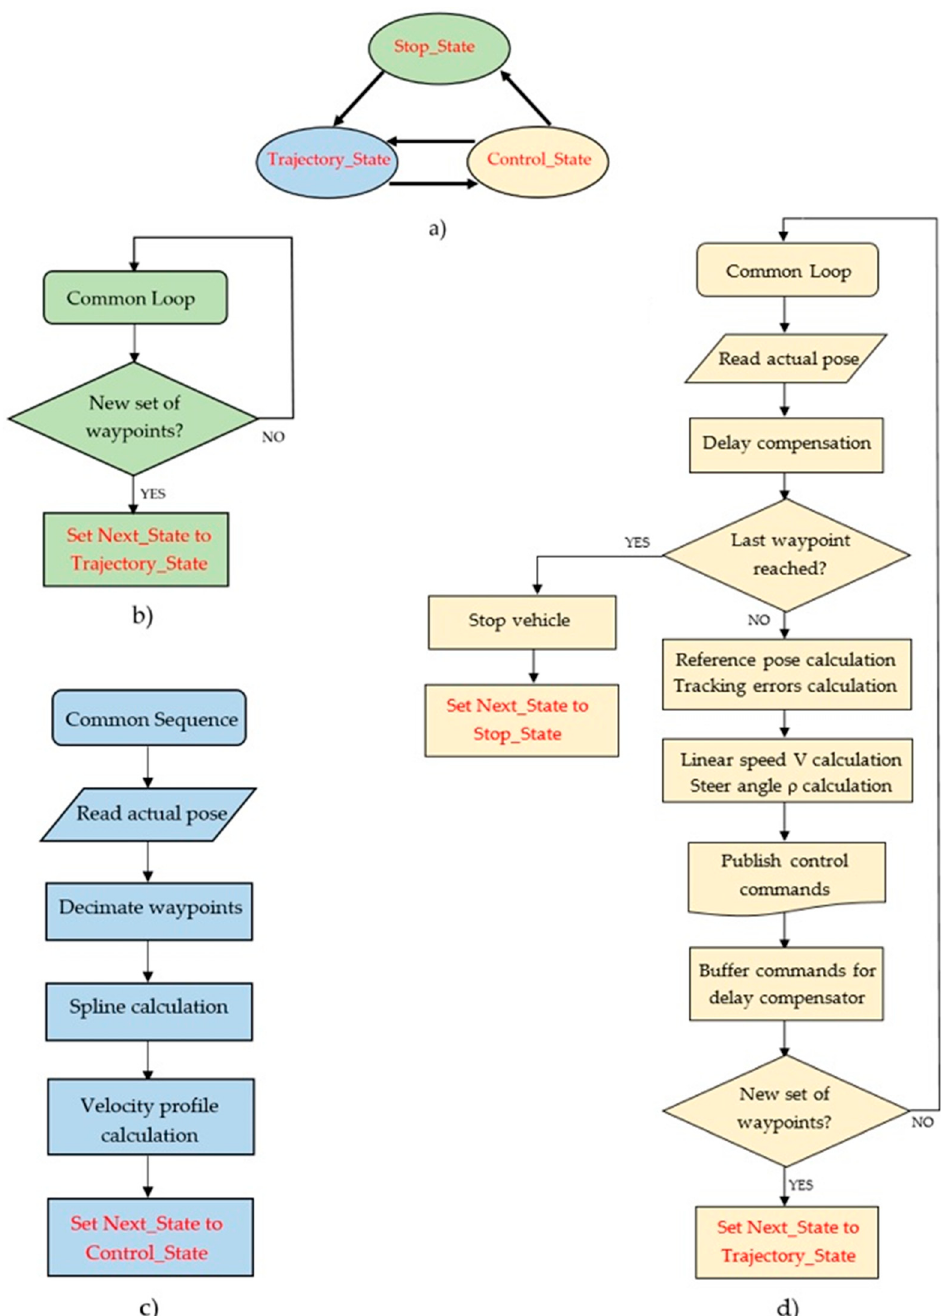
Figure 9. “Controller_node” operation: state machine is shown in ( a ), and the work flows of “Stop_State”, “Trajectory_State” and “Control_State” are shown in ( b ), ( c ) and ( d ), respectively. The “Waypoint_Tracking_Controller” package is publicly available through GitHub